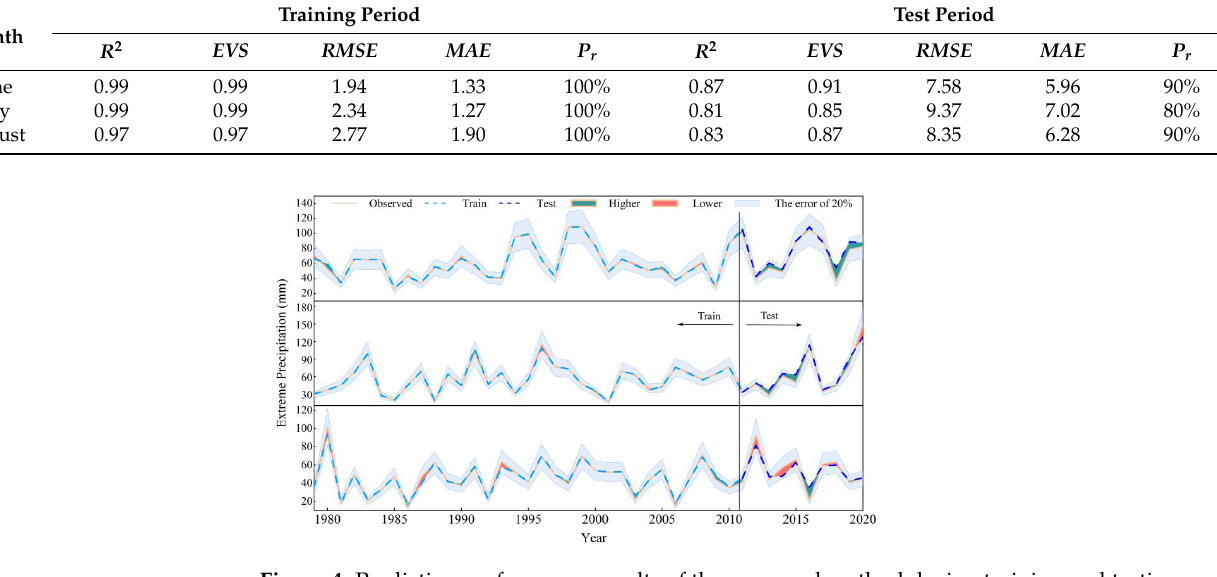
Table 2. Evaluation of the proposed model.